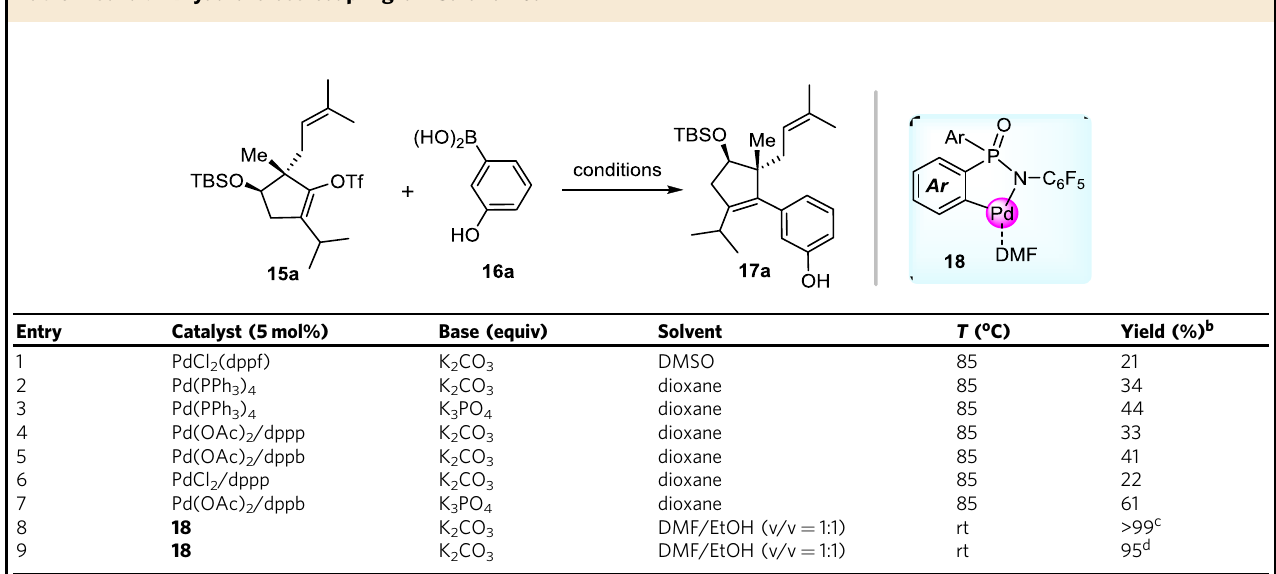
Table 1 Suzuki – Miyaura cross-coupling of 15a and 16a a